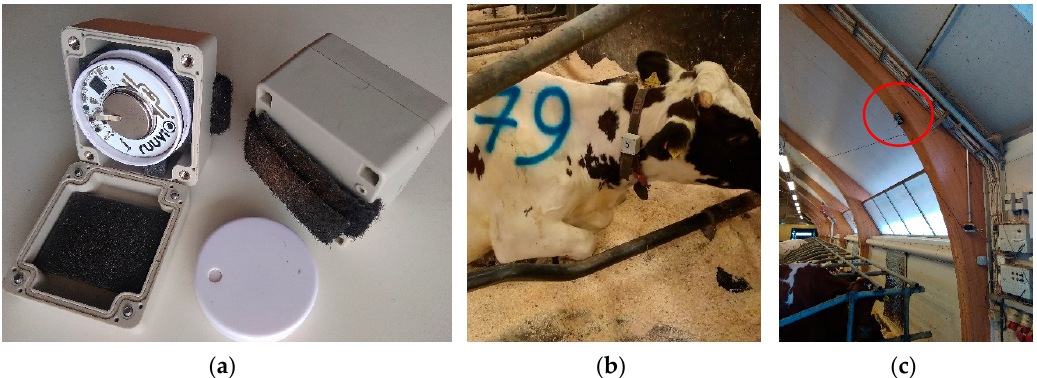
Figure 1. Components of the location and acceleration measuring system installed in a barn: RuuviTag inside a protecting plastic box ( a ), tag on the cow collar ( b ), receiving station installed on a barn construction ( c ).